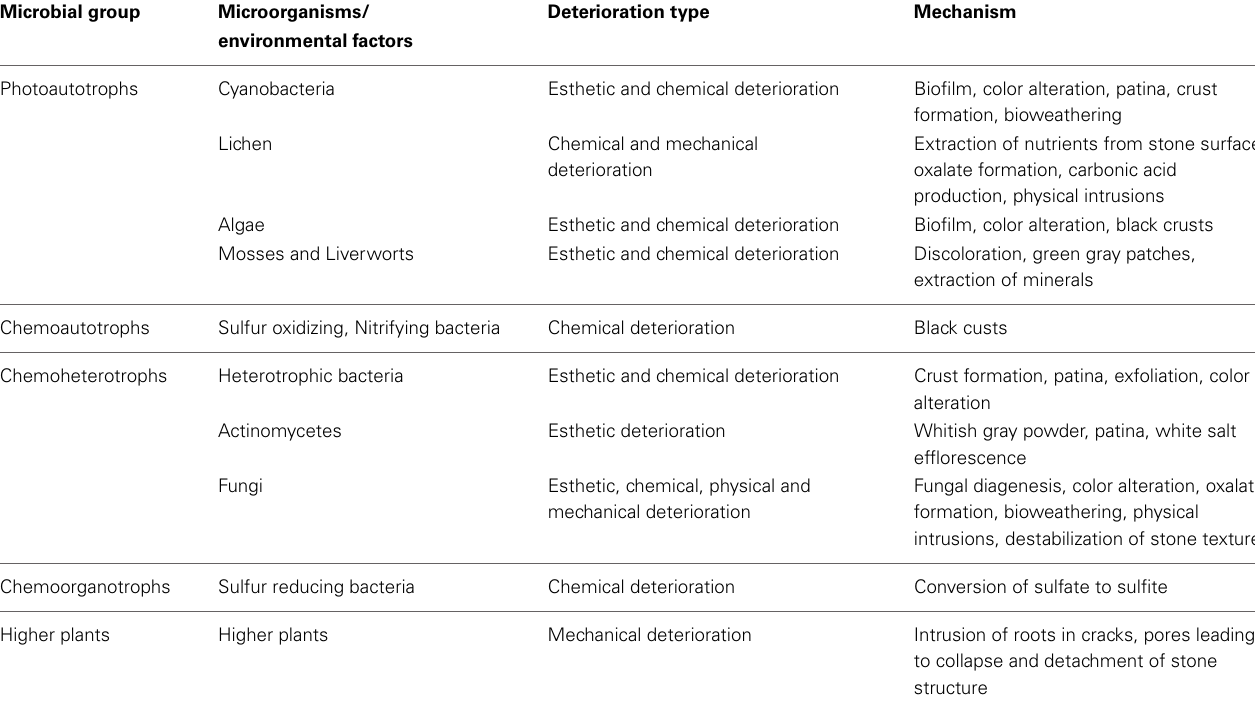
Table 2 | Microorganisms and environmental factors involved in biodeterioration of architectural buildings and artworks (Source: Dakal and Cameotra,